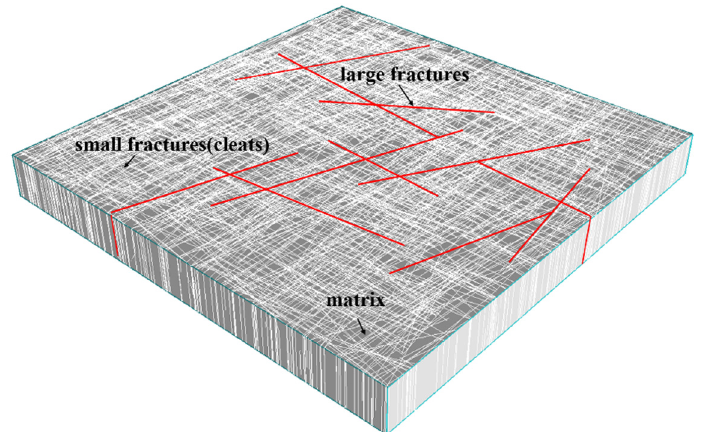
Figure 1. Schematic of coalbed methane reservoir with multiscale natural fractures (Gray ground color: matrix; white line: small fractures; red line: large fractures).